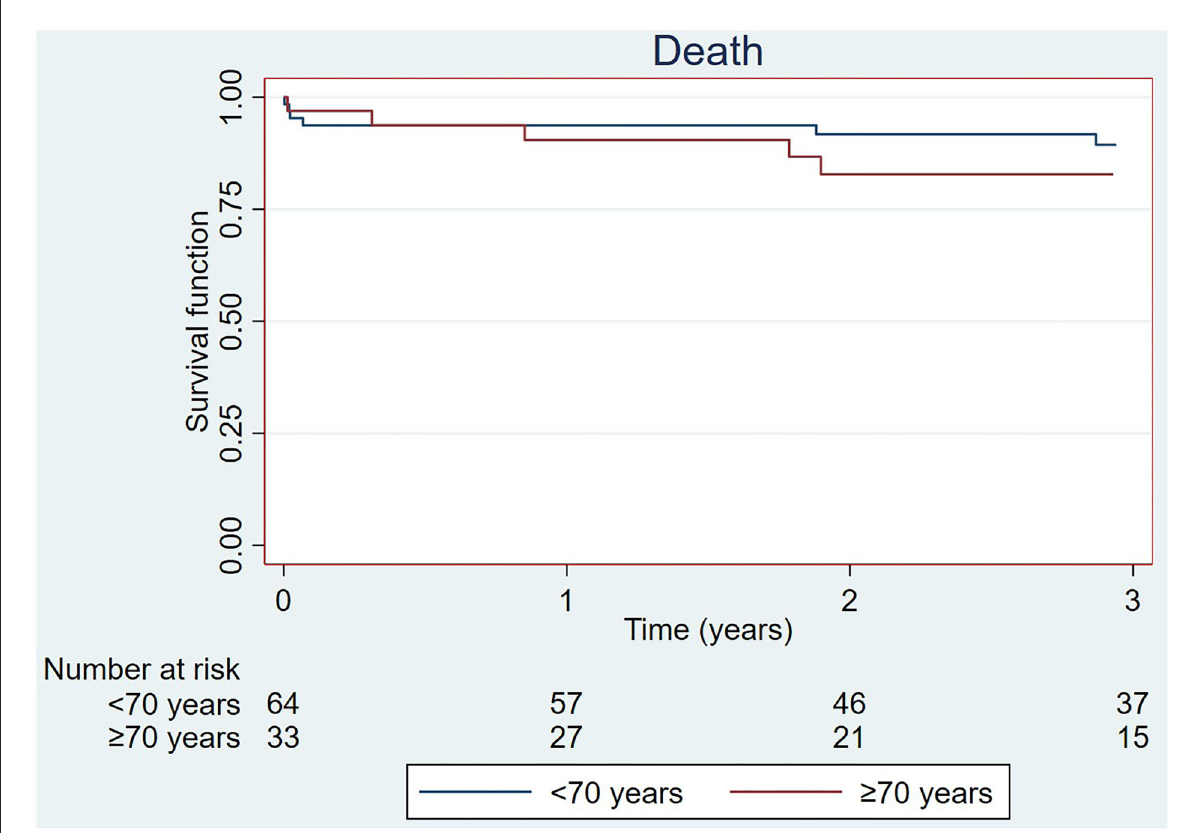
FIGURE7 Survival of the cohort ≥ 70 years and that of the population < 70 years with finished BPA therapy treated at the same center during the same period. BPA, balloon pulmonary